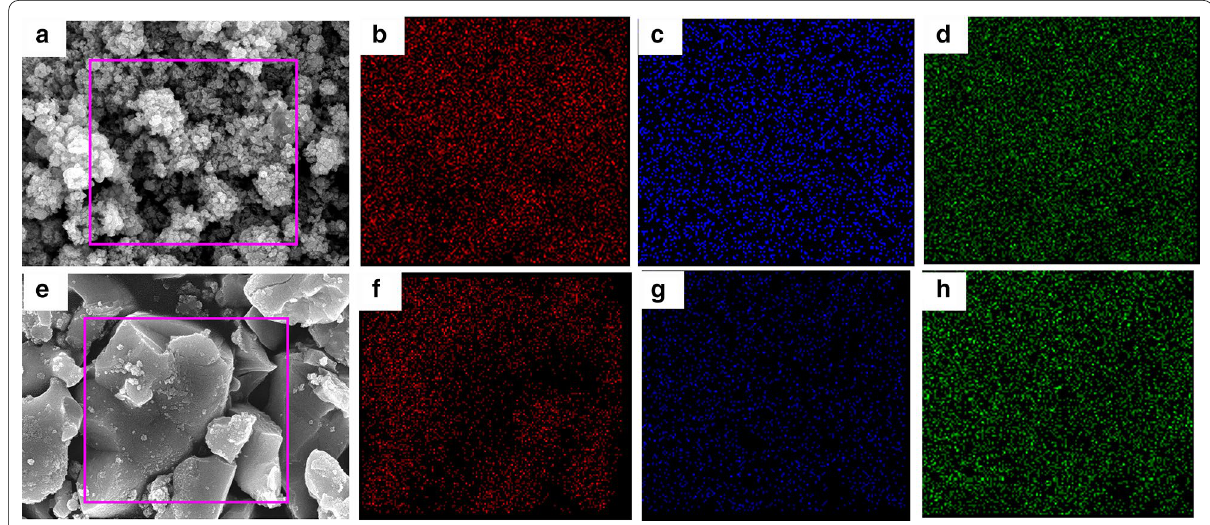
Fig. 3 EDX elemental mapping of b Cu, c Sn and d S of the as-prepared CTS; f Cu, g Sn and h S of the annealed